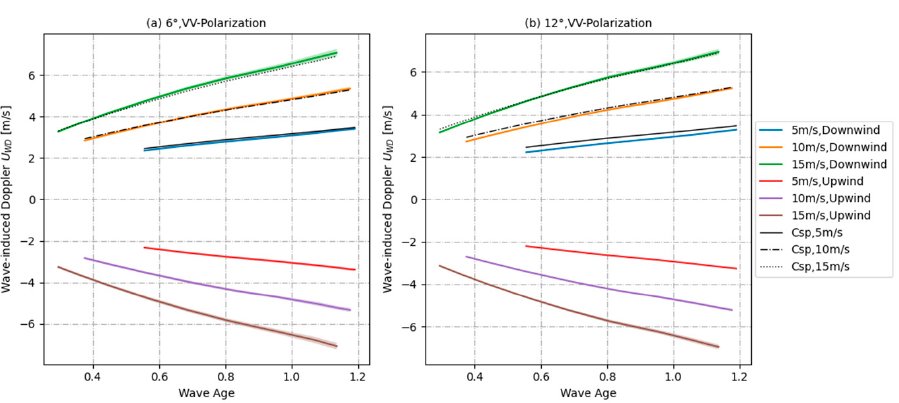
Figure 16. Contribution of wave age to U WD at 5, 10, and 15 m/s wind speeds with radar incidence angles of 6° and 12°, radar azimuth of 0°, wind directions of 0° and 180°, and no swell. The colored solid lines indicate U WD, the black lines indicate Csp , and the corresponding colored shading is the standard deviation.